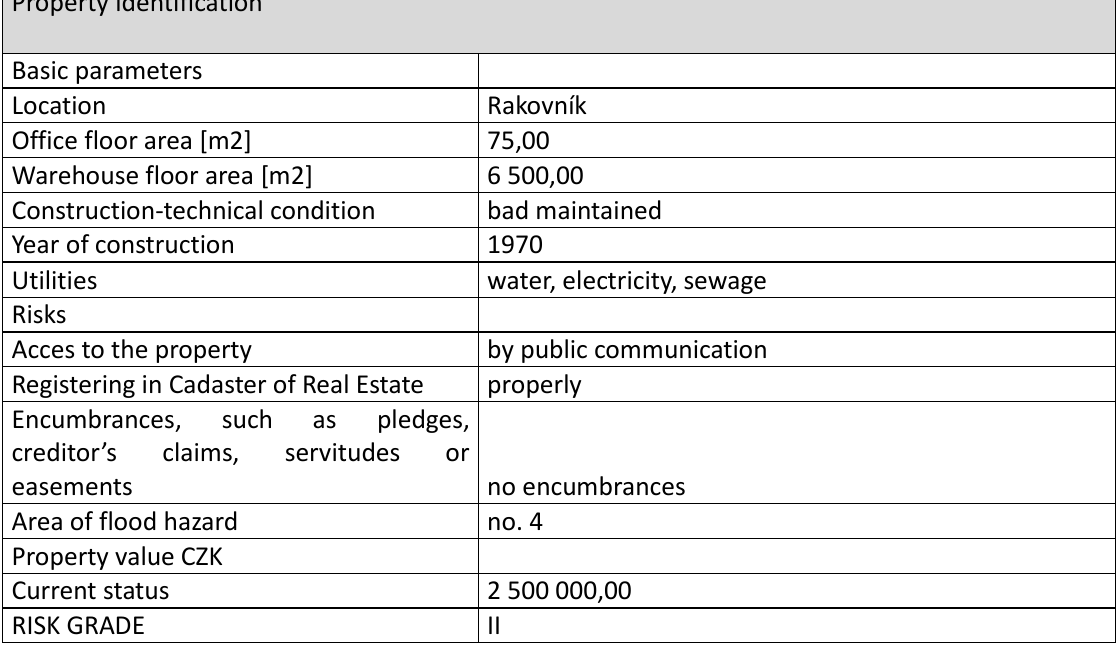
Table 6 - Property No. 3 (own source) Property